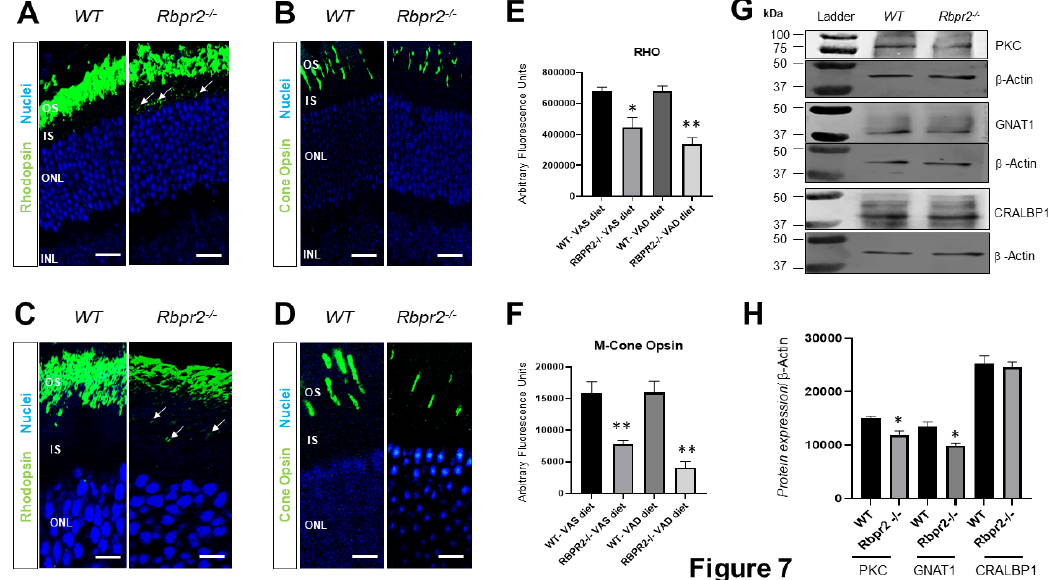
Figure 7. Immunohistochemical analysis for rhodopsin and cone opsin in retinas of Rbpr2 − / − mice. Levels and localization of rhodopsin (Rho) in wild-type (WT) and Rbpr2 − / − mice on either vitamin A-sufficient diets ( A ) or vitamin A-deficient diets ( C ). Red/green medium wavelength cone opsin (M-opsin) staining in WT and Rbpr2 − / − mice on either vitamin A-sufficient diets ( B ) or vitamin A-deficient diets ( D ). Loss of cone opsin staining was observed in Rbpr2 − / − mice under both dietary conditions (** p < 0.005). Rbpr2 − / − mice on either vitamin A diet showed a significant loss of rhodopsin staining (* p < 0.05; ** p < 0.005) and mislocalization to the inner segments (arrows in panels A and C). Images in panels ( A – D ) are representative of immunostained retinal sections ( n = 5–7 sections per eye) imaged from n = 8 animals per genotype and age group (50:50 male to female ratio). ( E , F ) Quantification of rhodopsin and cone-opsin in OS among various genotypes and dietary conditions (* p < 0.05; ** p < 0.005). Scale bars = 75 µ m ( A , B ). Scale bars = 25 µ m ( C , D ). OS, outer segments; IS, inner segments; ONL, outer nuclear layer; INL, inner nuclear layer. ( G ) Protein expression analysis of components of the photoreceptors. Western blot analysis for PKC, GNAT1, and CRALBP1 in total protein preparations of the retina in vitamin A-deficient Rbpr2 − / − mice and WT mice (pooled n = 6 retinas per genotype and age). β -actin gene expression was used as the internal control. ( H ) Protein densitometry analysis and quantification. The statistical analysis was performed using an unpaired two-tail Student t -test by comparing values from age-matched Rbpr2 − / − and WT mice. * p <